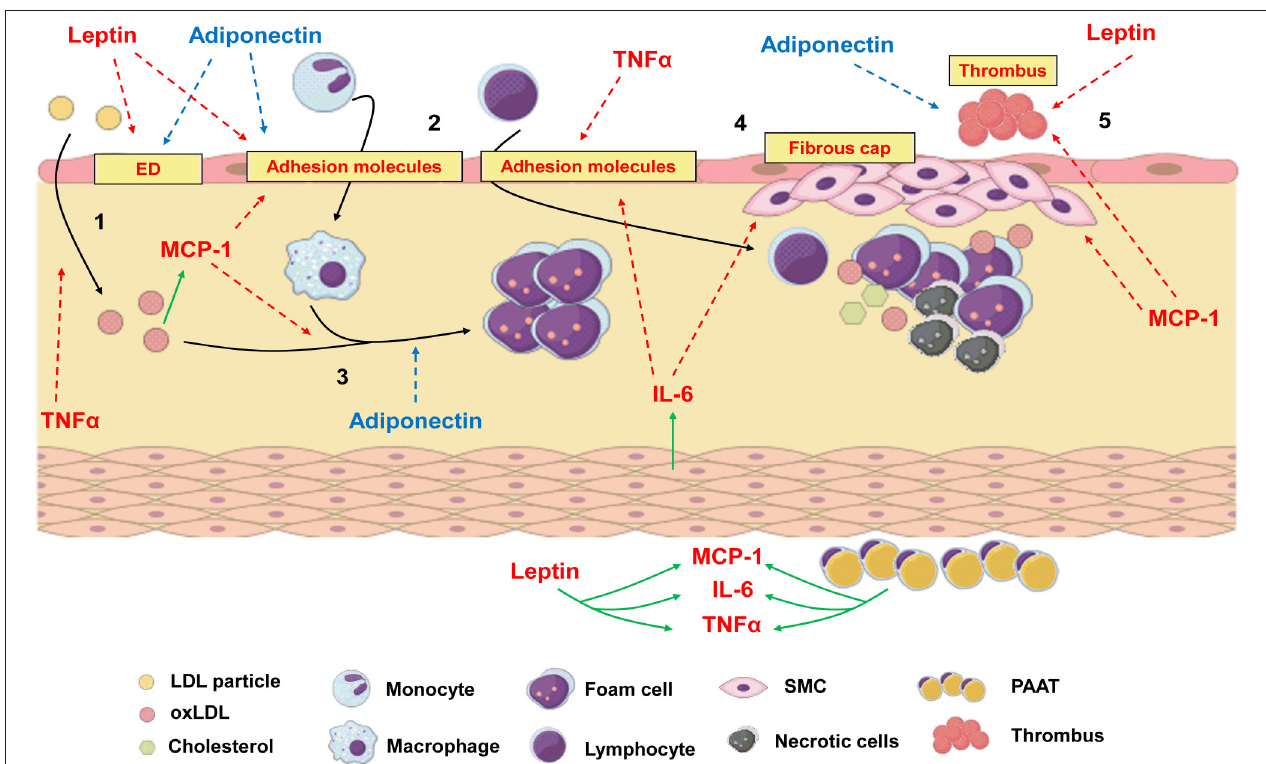
FIGURE 4 | The process of atherogenesis can be influenced by diverse adipokines.1: Endothelial dysfunction (ED) and transmigration of LDL particles to subendothelial space can be worsen by leptin and TNF α . Adiponectin, which is reduced in obesity, recovers endothelial function. 2: Once in subendothelial space LDL is oxidized (oxLDL), which is positively related to MCP-1 levels. Leptin, IL-6, MCP-1 and TNF α increase the expression of adhesion molecules in endothelium and increase leucocyte transmigration. 3: Monocytes turn into macrophages under the stimulus of MCP-1 and phagocytes oxLDL, turning into foam cells. Adiponectin inhibits phagocytosis of oxLDL and foam cell formation. 4 : IL-6 can be produced by local smooth muscle cells (SMC) under the stimulus of angiotensin II. Along with MCP-1, it increases recruitment and proliferation of SMC and extracellular matrix deposition to form a fibrous cap around a lipid-rich necrotic core. 5 : Due to stimulation of matrix metalloproteinases and prothrombotic molecules, MCP-1 and leptin favors plaque rupture and thrombus formation, while adiponectin inhibits thrombosis. Periadventitial adipose tissue (PAAT) and leptin induce the production of proinflammatory adipokines. Red arrows represent proinflammatory pathways which are stimulated during obesity and contribute to atherogenesis. Blue arrows represent anti-inflammatory pathways which are inhibited during obesity since adiponectin levels are low. Green arrows represent production or stimulation of adipokine